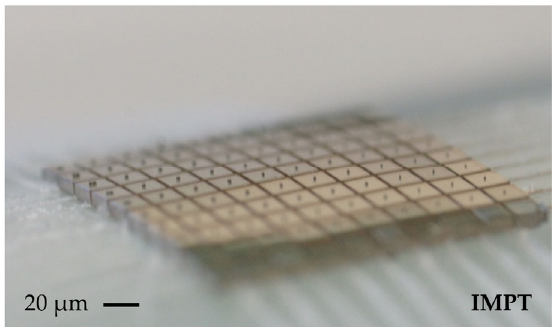
Figure 7. Diced chips on adhesive tape.